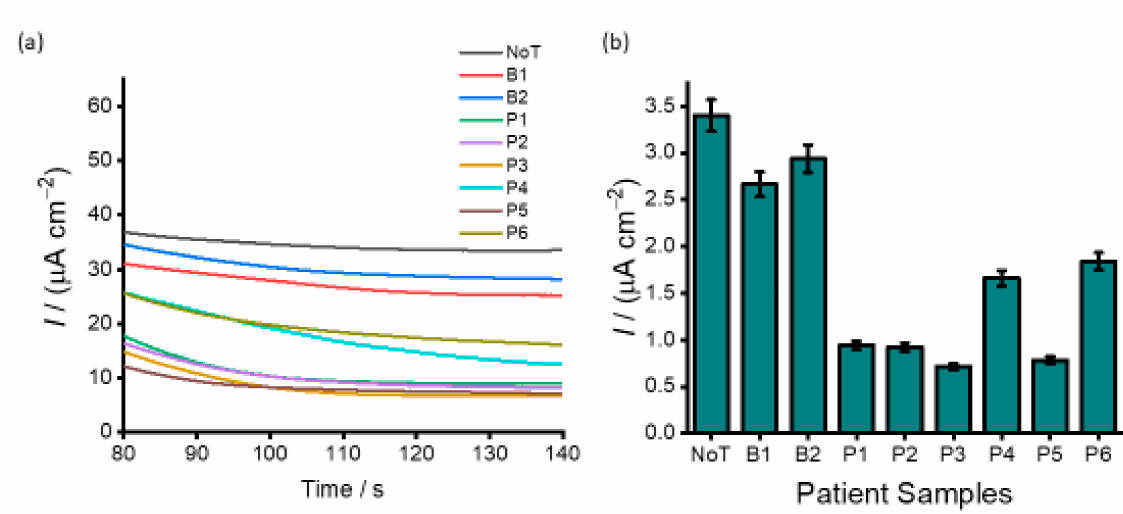
Figure 7. Analysis of patient samples. ( a ) Current density responses obtained for two benign ovarian cancer patients (B1–B2) and six patients of high-grade serous subtype ovarian cancer (P1–P5); ( b ) corresponding bar figure showing the magnitude of the current density response obtained for benign and high-grade serous subtype ovarian patient samples. Each data point represents the average of three repeat experiments, and error bars represent the standard deviation of measurements (%RSD ≤ 5% for n =